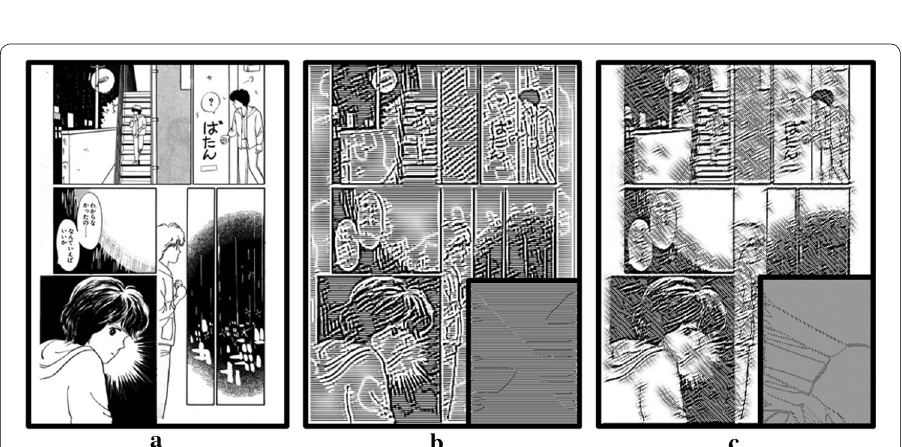
Fig. 8 Image transformation results for two different neurons of the first convolutional layer. a Original image, b transformation via 7th neuron, c transformation via 11th